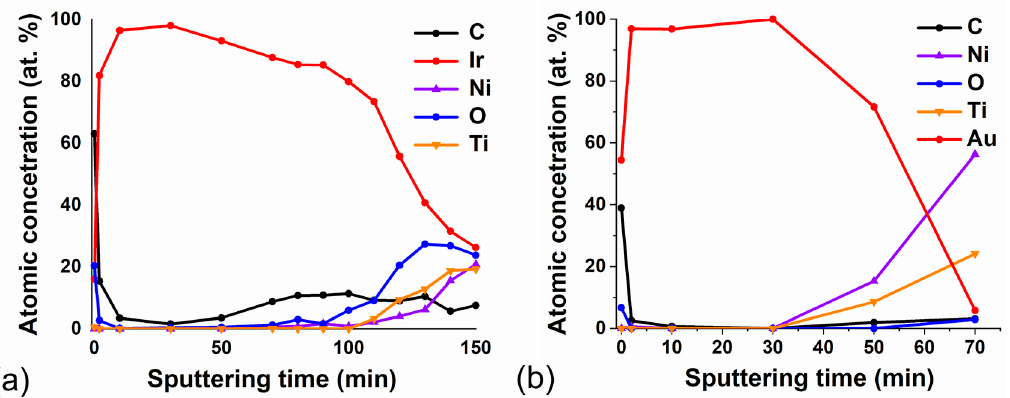
Figure 4. The XRS depth profiles of the element concentrations for noble metal sublayers on TiNi substrates ( a ) Ir’/TiNi and ( b ) Au/TiNi.